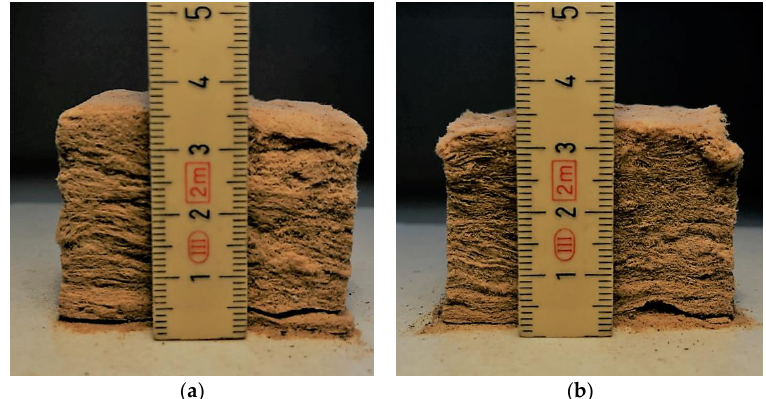
Figure 12. The height of the 50 mm cubic insulation test specimens after 30 min holding time as a function of the holding temperature. (The dashed line represents the 50 mm initial height.).